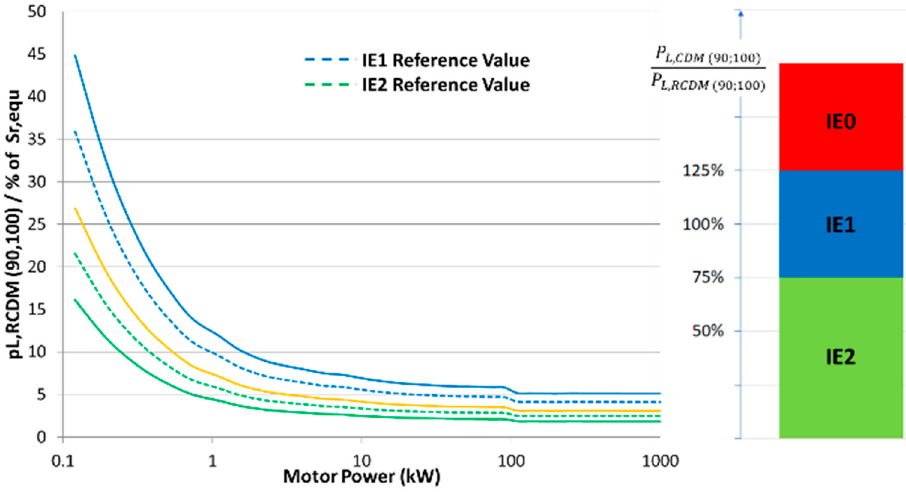
Figure 4. E ffi ciency levels and classes for CDM classification defined in the IEC 61800-9-2 Figure 4. Efficiency levels and classes for CDM classification defined in the IEC 61800-9-2 standard.